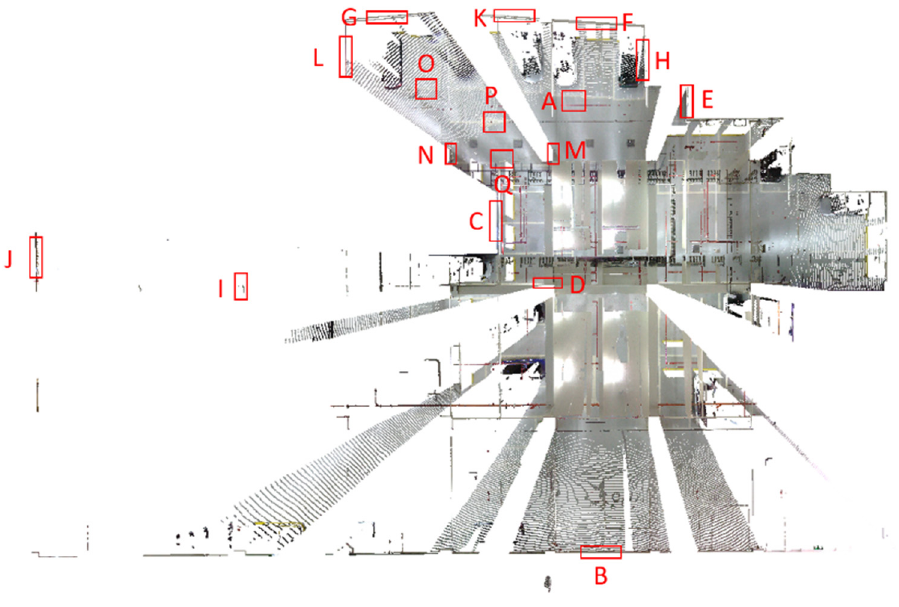
Figure 4. Locations of the selected 17 planes for calibration reference data.